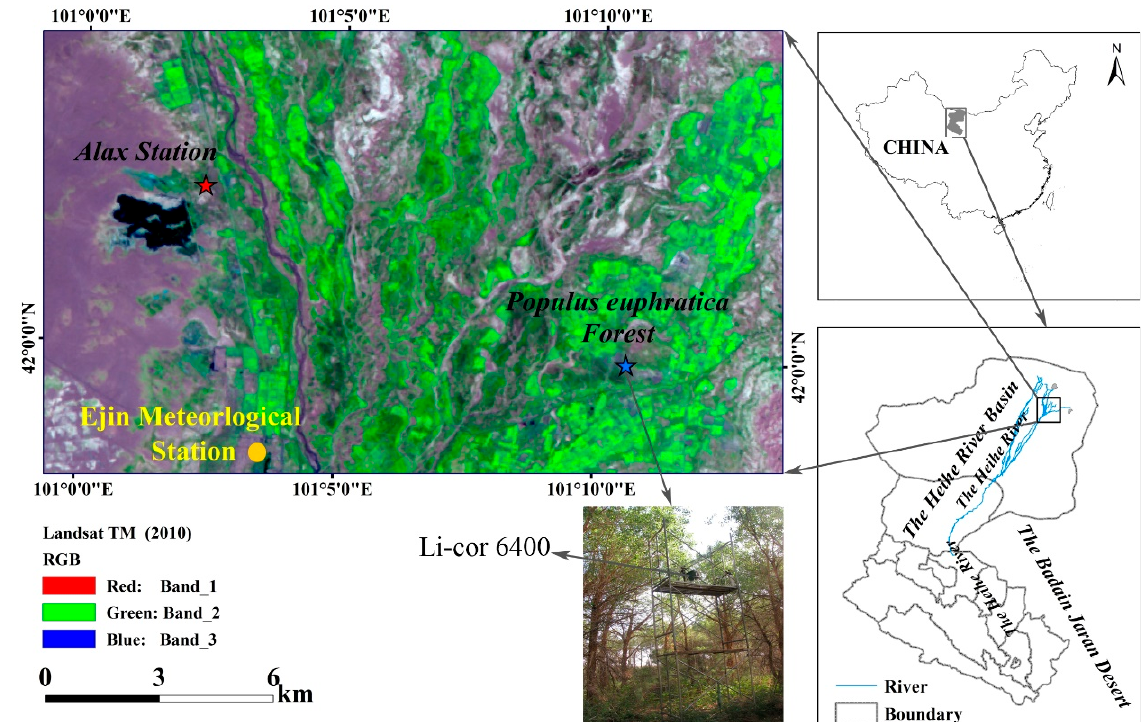
Figure 1. Map of the study area.